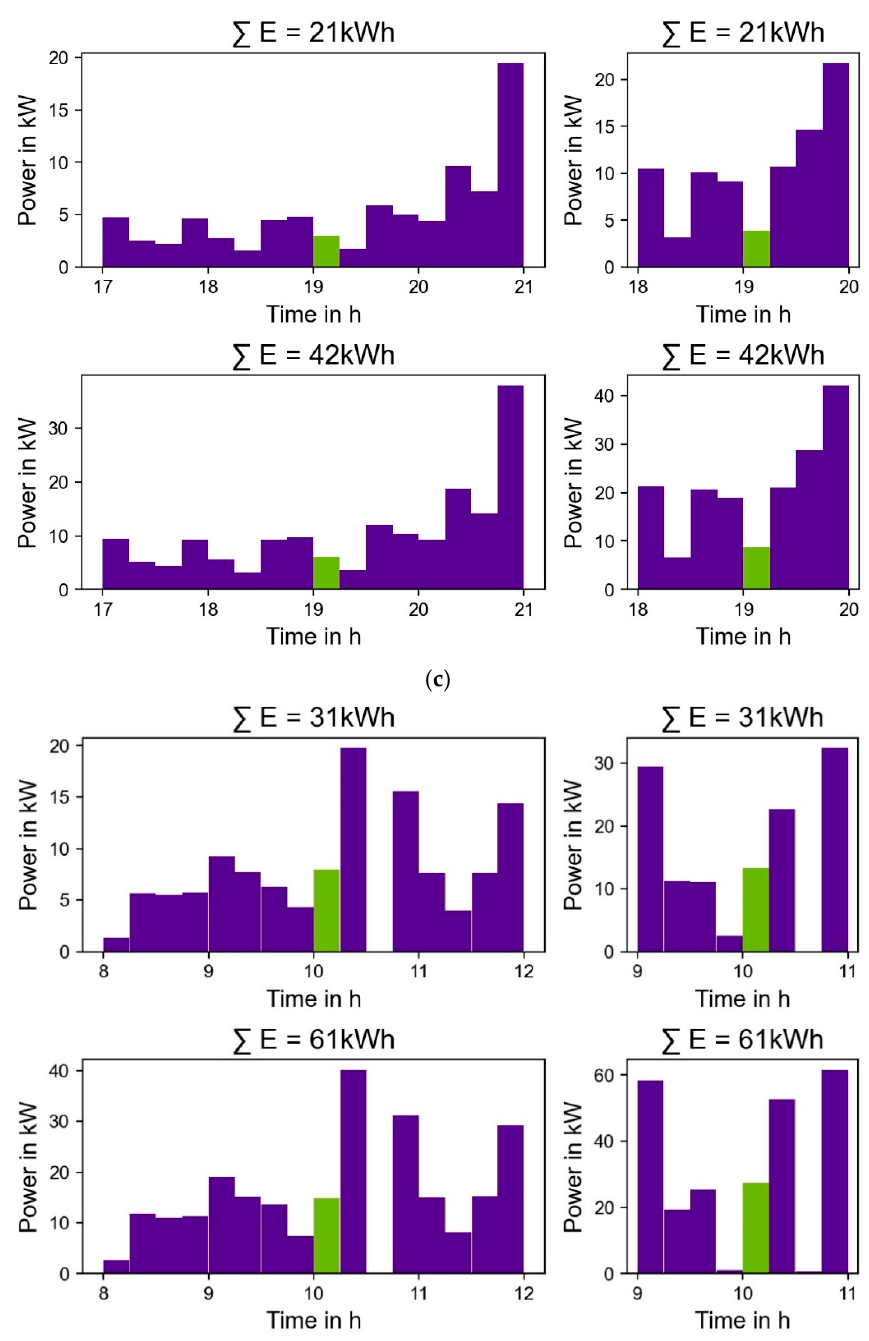
Figure 4. Optimal schedules of load reduction when minimizing the loss of charged energy on customers. On the left side, a time window of 4 h is used and on the right-hand side, a time frame of 2 h is used. The schedules with two different values of energy are presented. The green bar shows the time of the peak load: ( a ) Car park; ( b ) Office; ( c ) Residential; ( d ) Shopping center. By comparing the right and the left sides in Figure 4a–d, it is noticeable that a variation in energy results in a proportional change of the charging power (bar height), the pattern otherwise maintains a similar form. The change of powers can also be observed on the right side of the figures. It is observable that in case of office sites; significantly more load is reduced after the peak (green bar) as before that. In all other charging sites,